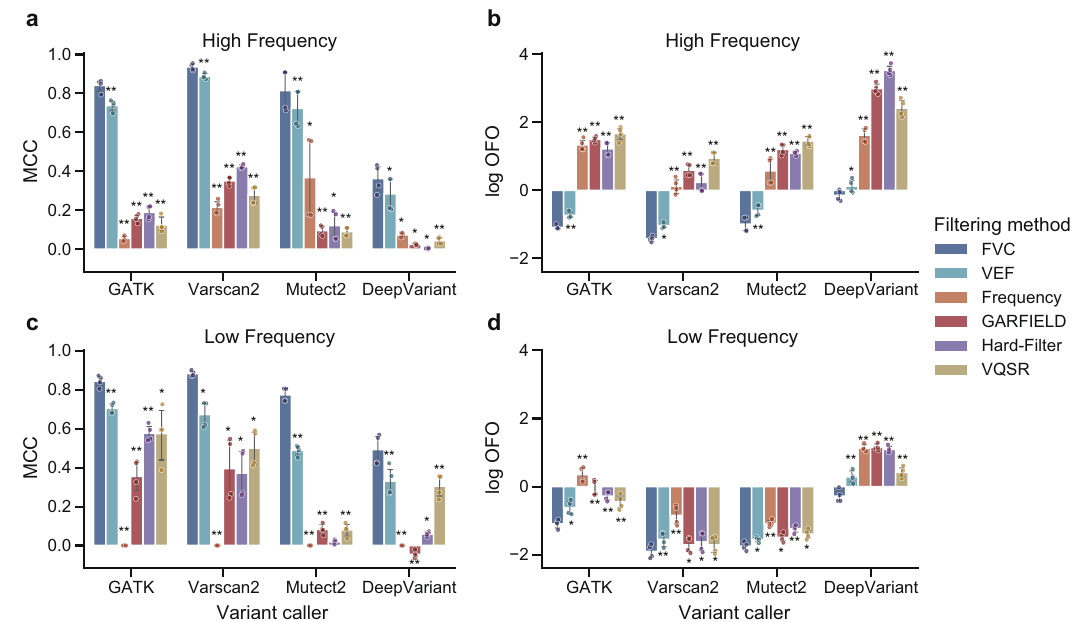
Fig. 3 The performance of different fi ltering methods when applied to high-frequency variants or low-frequency variants. The high-frequency variants and low-frequency variants used as testing data are derived from whole-genome sequencing datasets (HG001, HG003, HG004, and HG006) at 30× coverage and identi fi ed by GATK, Varscan2, Mutect2, and DeepVariant, separately. Variant calls with variant allelic frequency (VAF) of more than 20% are de fi ned as high-frequency variants. The other variant calls are de fi ned as low-frequency variant calls. The performance of the fi ltering methods is assessed on the a high frequency variants using MCC; b high frequency variants using OFO; c low frequency variants using MCC; and d low frequency variants using OFO. The circle indicates the metric score achieved by FVC when applied to each speci fi ed testing data. The error bar indicates the 95% con fi dence intervals ( n = 4 biologically independent samples). Asterisk denotes the signi fi cance of the comparison using a one-sided paired T-test (* p < 0.05, ** p < 0.001), where the null hypothesis is that the FVC performs no better than the compared method. FVC consistently shows log OFO< 0 when applied to high-frequency and low-frequency